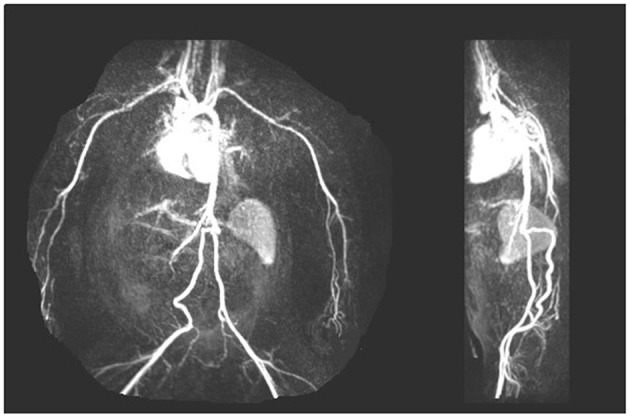
Arteriogram showing early bifurcation of the aorta below the renal vessels with absence of the aorta below the superior mesenteric artery in a CAKUT patient with urogenital sinus anomalies.